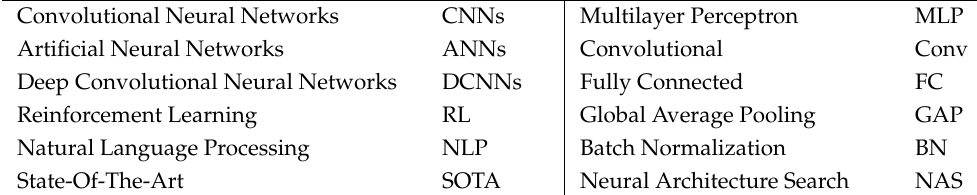
Table 6. Acronyms in the